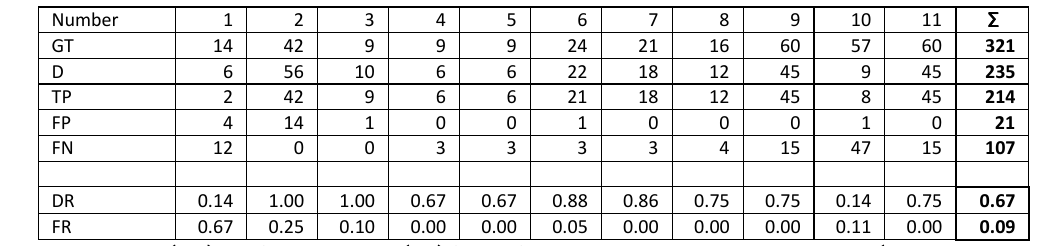
Detection rate (DR) and false alarm rate (FR) for the facades shown in Figure 7 and Figure 8 (GT= Ground Truth, D =